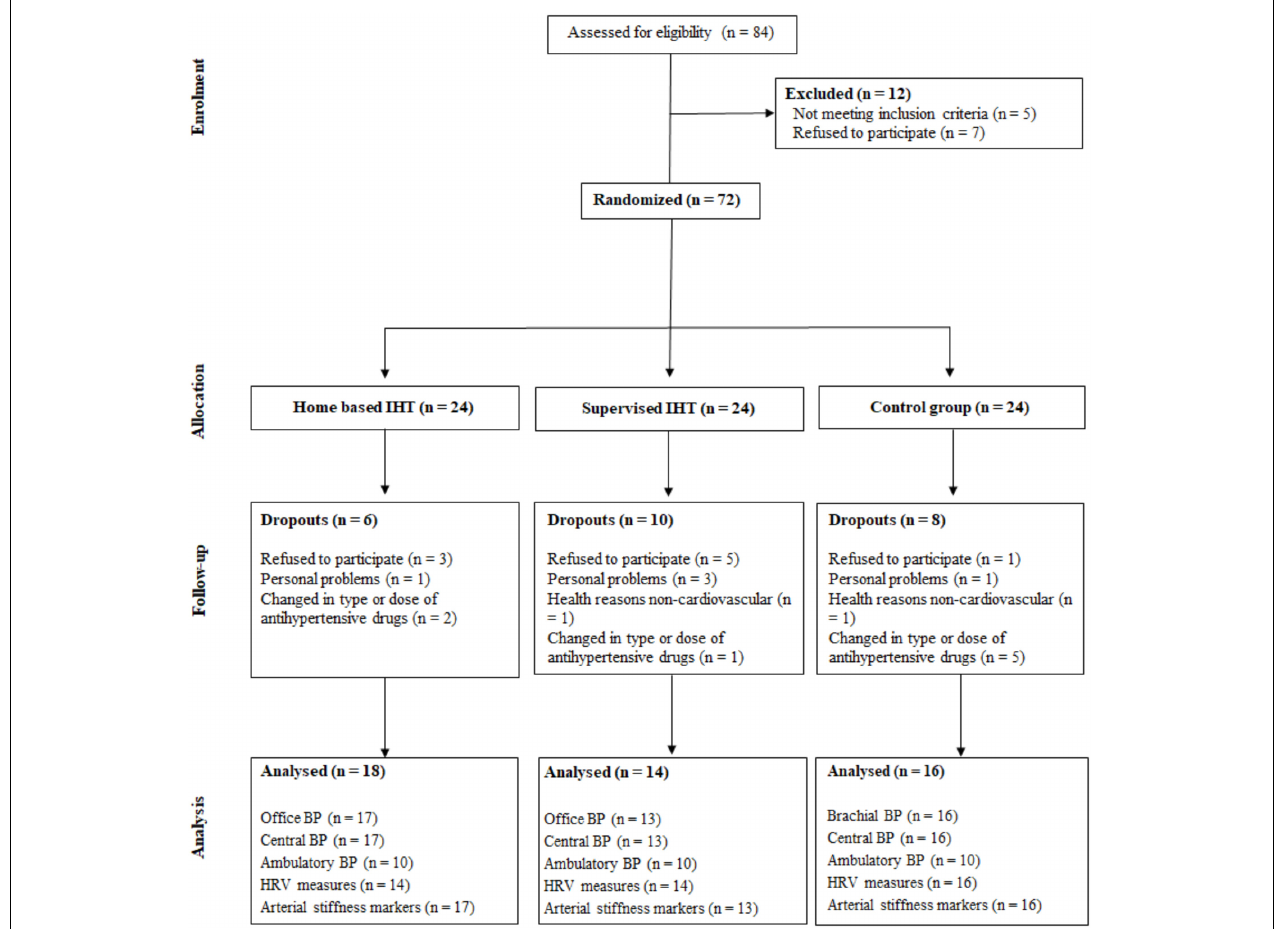
FIGURE 1 | Flowchart of study. IHT, isometric handgrip training. BP, blood pressure. HRV, heart rate variability.